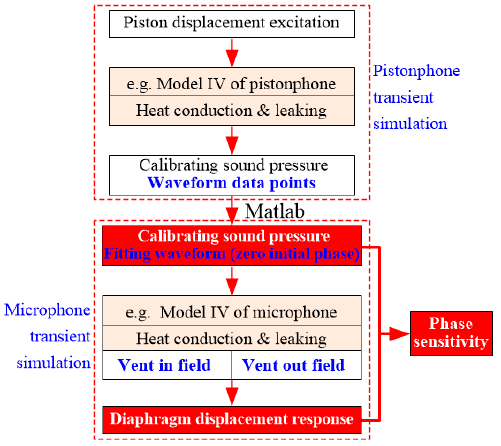
Figure 13. Flow chart of the time domain simulation.